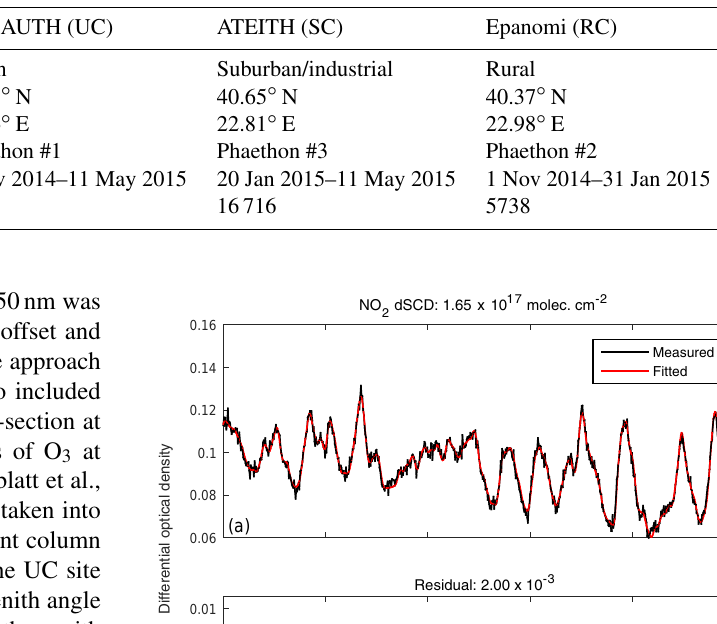
Table 1. Information on campaign locations and measurements performed there.